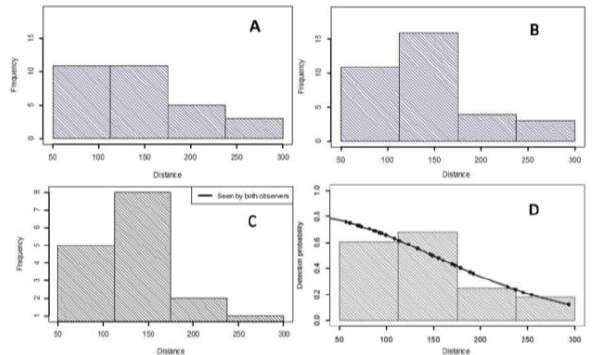
Figure 10. Scaled histograms of perpendicular distances and the predicted detection probability functions for harbour porpoise groups. A) Front observers, B) rear observers, C) both observers and D) pooled detections with sightings fitted to a half-normal model where